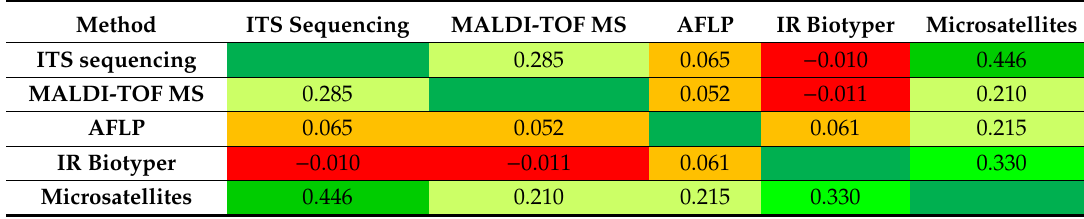
Table 2. Correlation between the results obtained with five typing methods used for 96 Candida auris